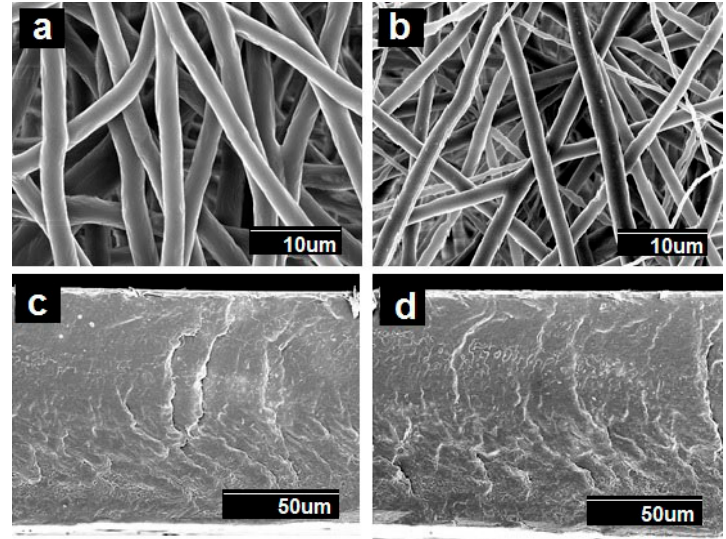
Figure 1. Scanning electron microscopy (SEM) images of the surface view and the cross-section of the polycaprolactone (PCL) fibers, with and without palladium nanoparticles (PdNPs), and their respective annealed films: ( a ) Surface view of the neat PCL fibers; ( b ) Surface view of the PCL/PdNP fibers; ( c ) Cross-section of the neat PCL film; ( d ) Cross-section of the PCL/PdNP film.